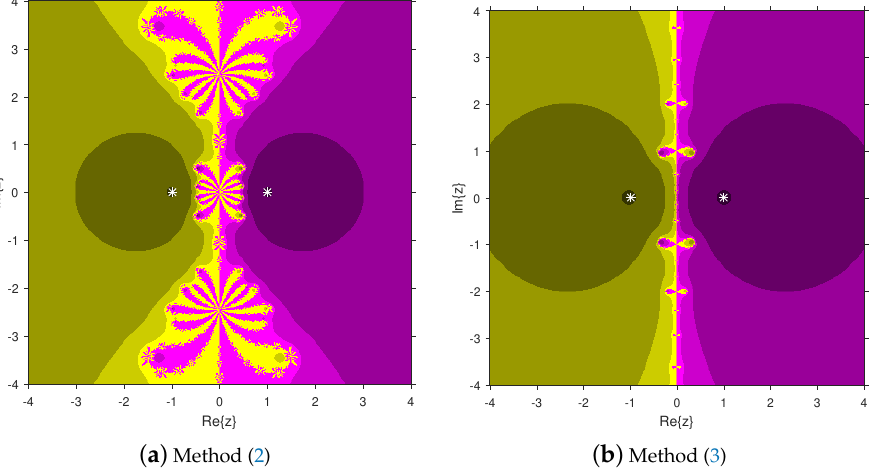
Figure 1. Comparison of attraction basins associated with second-degree polynomial O 1 ( z ) = z 2 −